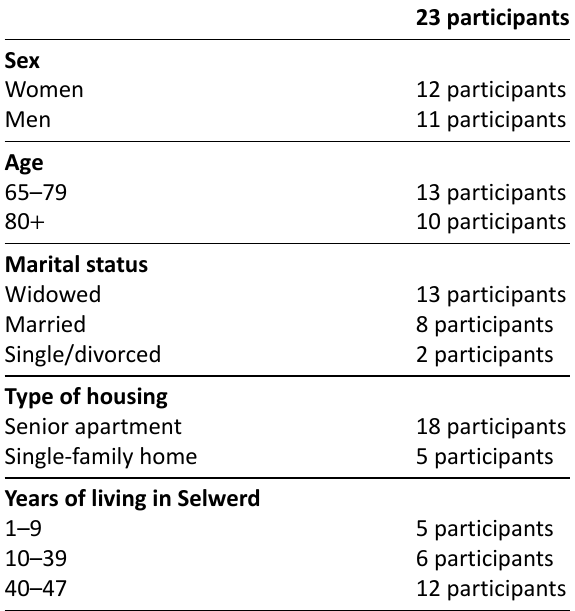
Table 1. Characteristics of the